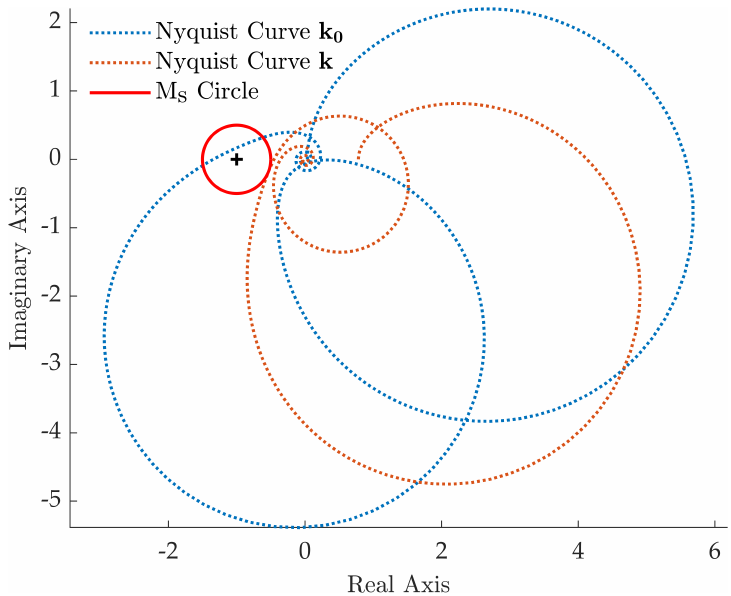
Figure 6. Test case 2: Nyquist curve of L ( j ω ) .